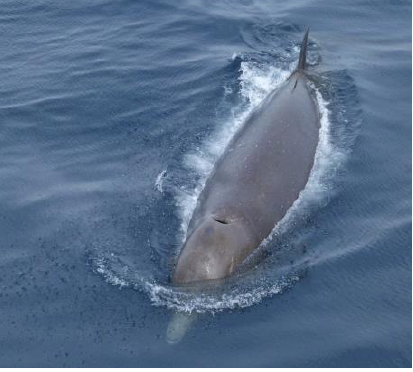
Figure 10. Northern bottlenose whale. Photo credit: Jane Sproull Thomson.